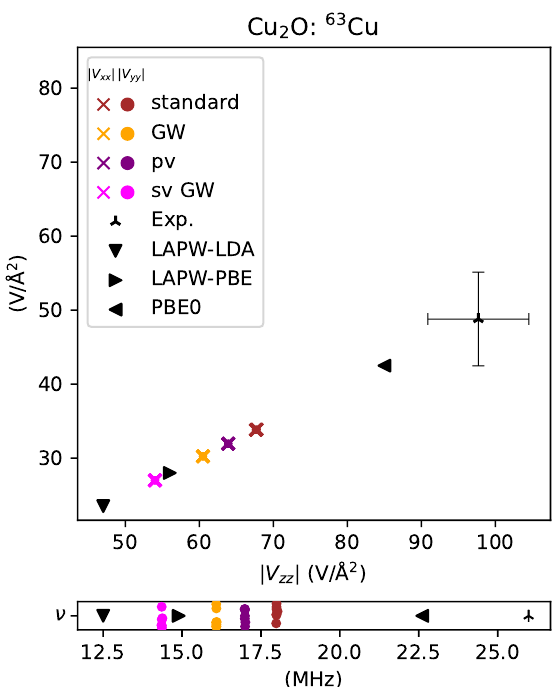
Figure 6. EFG plot for 63 Cu in Cu 2 O is shown at the top; the corresponding NQR frequency is shown underneath. The system is symmetric, hence V xx = V yy = − V zz /2. Colored markers show a computed value for each PAW potential and experimental data [49] is shown as a three-pointed star. The potential closest in agreement to experiment is the standard potential and was found to be off by δ = 31% and the furthest potential is sv GW, off by δ = 45%. Literature DFT data [29], shown in black, were calculated using an LAPW method with different exchange-correlation energy functionals. The V zz value was computed to be